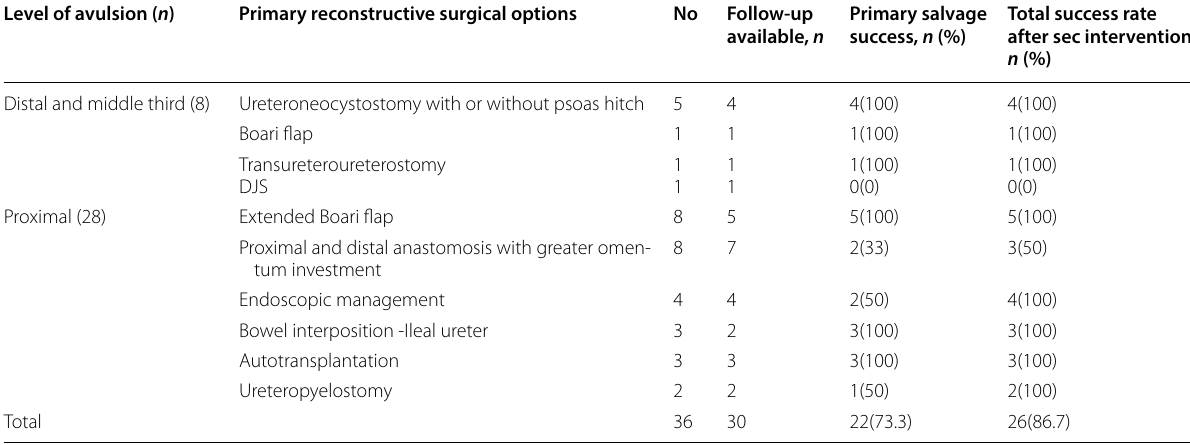
Table 2 Results of various reconstructive procedures done for ureteric avulsion following ureteroscopy according to level of